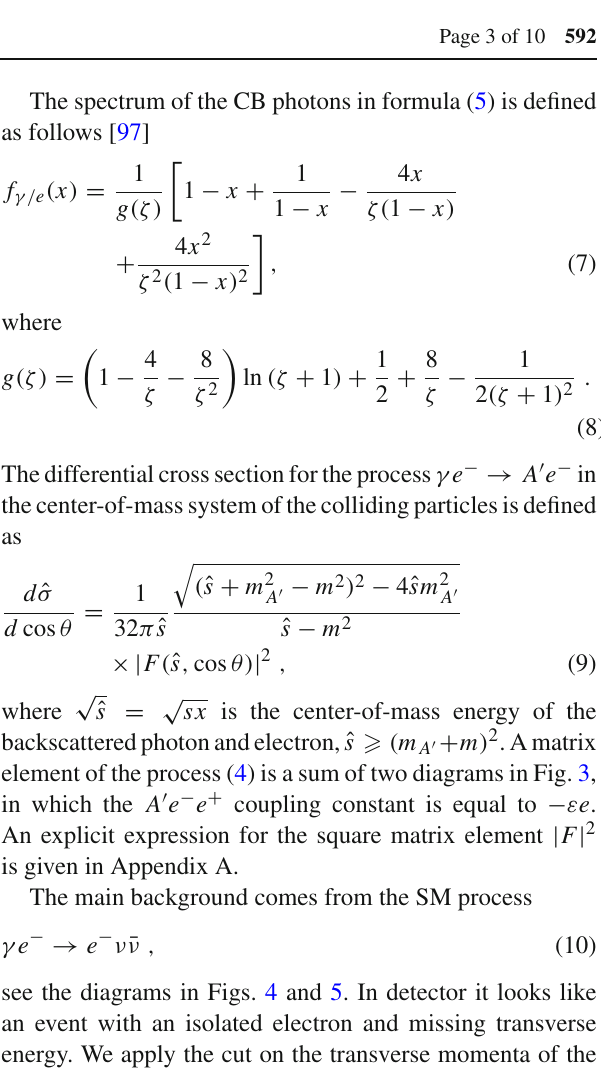
Fig. 3 The diagrams for the production of the dark photon in the γ e − collision, with its subsequent invisible decay into dark matter particles